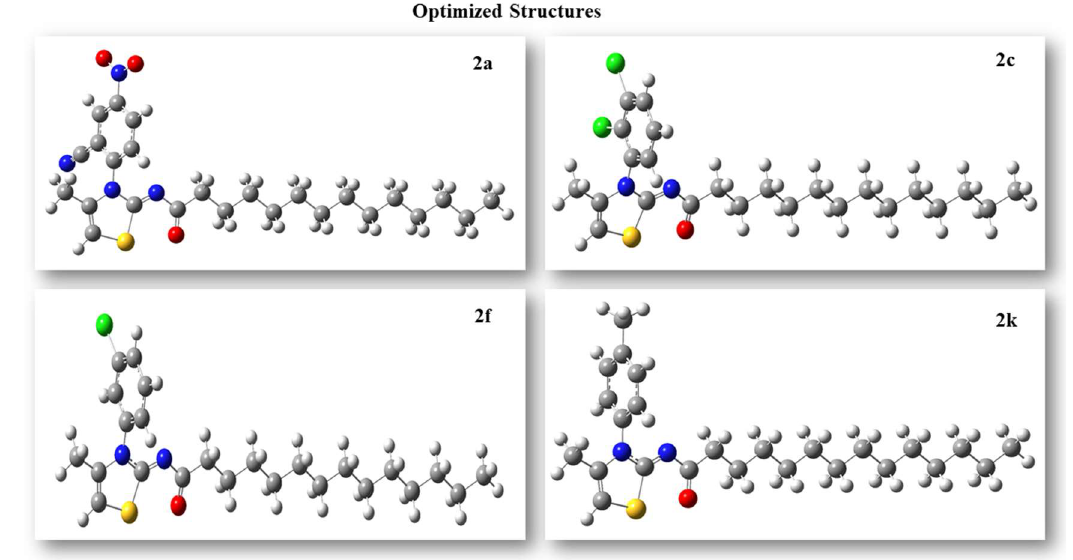
Figure 4. Optimized structures of compounds 2f, 2a, 2k, and 2c.